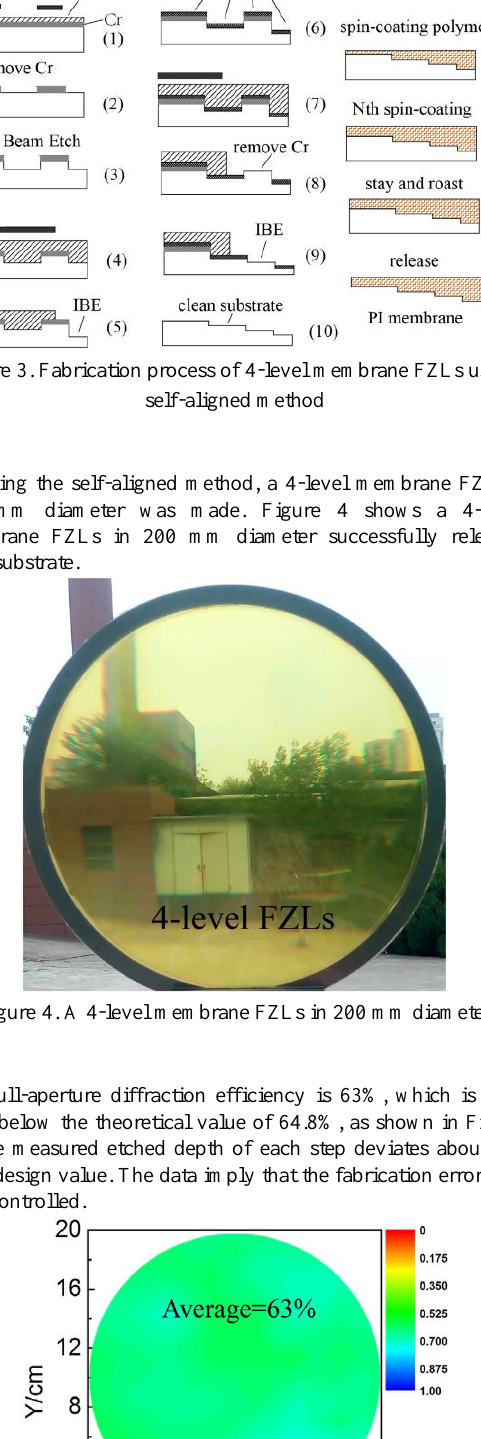
Figure 5. Diffraction efficiency of a 4-level membrane FZLs